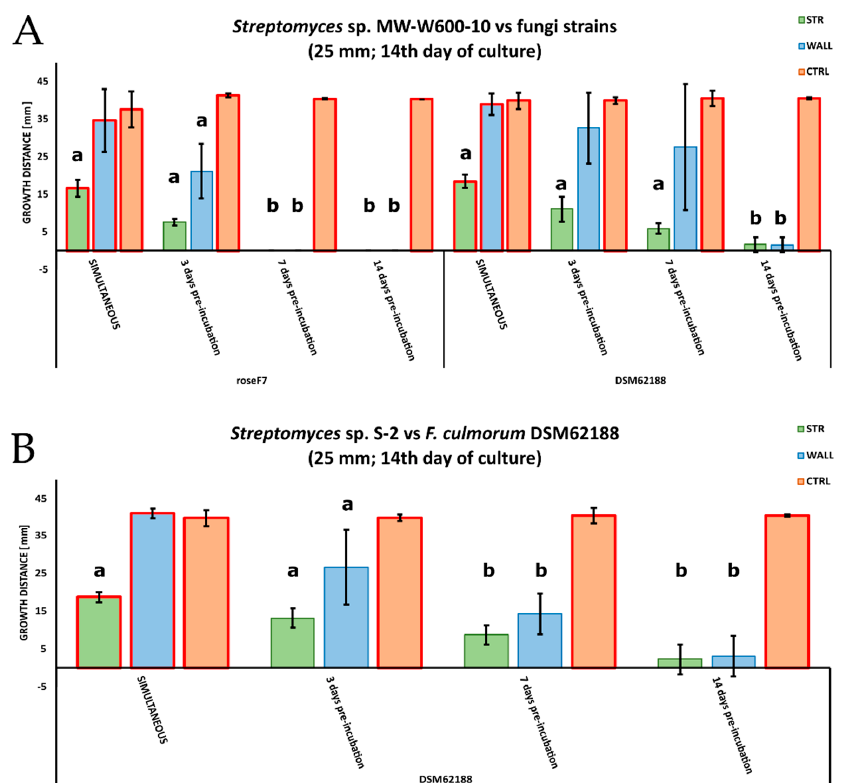
Figure 3. Inhibition of fungal growth by coal-related Streptomyces strains. ( A ) Effect of co-culture with MW-W600-10 strain on the growth of Nigrospora oryzae roseF7 and Fusarium culmorum DSM62188; ( B ) effect of co-culture with S-2 strain on the growth of F. culmorum DSM62188. The charts compare the growth of fungal mycelium toward Streptomyces streak colonies (STR), the plate wall